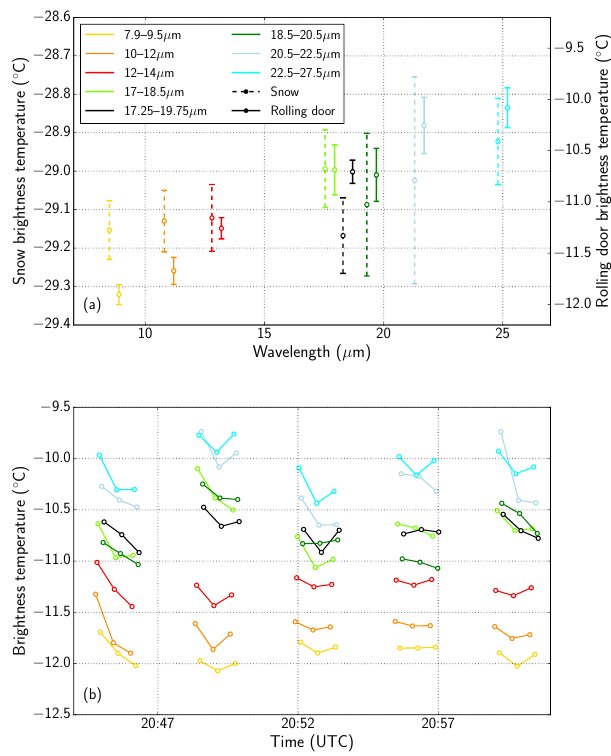
Figure 4. (a) Mean and standard deviations (error bars) of the de- trended brightness temperatures along 10 sequences (i.e. 30 consec- utive measurements) for measurements taken on snow on 12 April (15:10–15:42UTC) and along 5 sequences on the rolling door on 11 April (21:45–22:00UTC). For 12 April, T HBB = 20 ◦ C and T ABB = − 9 . 5 ◦ C. For 11 April, T HBB = 45 ◦ C and T ABB = 15 ◦ C. (b) Temporal evolution of brightness temperature for the five se- quences acquired on the closed rolling door on 11 April. The 30– 50µm band is not shown because it suffered from the temperature stability problem mentioned in Sect.